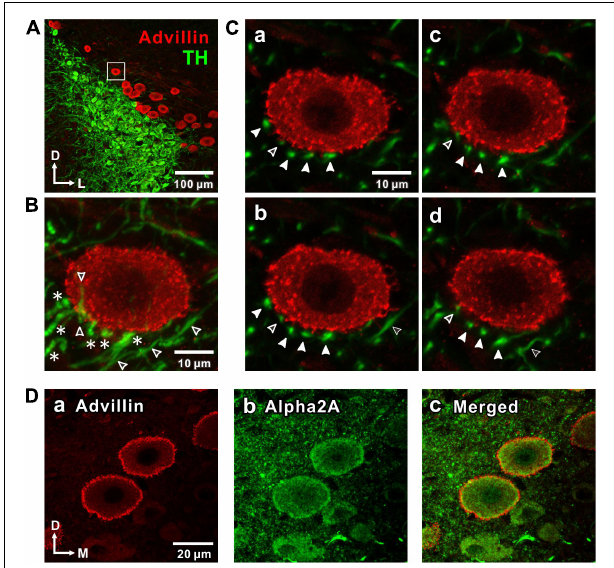
FIGURE 1 | Noradrenergic projections from the locus coeruleus (LC) to the mesencephalic trigeminal nucleus (MTN) neurons and expression of α 2 -adrenergic receptor ( α 2A -Ars) in MTN neurons. (A) A confocal image (10x magnification) of a coronal brain section showing LC nucleus and MTN, in which LC neurons were immunostained with tyrosine hydroxylase (TH; green), while MTN neurons were immunostained with advillin (red). The region enclosed with a square was further visualized at 100x magnification as shown in a larger scale in (B,C) . (B) A Z-stack projection of 8 serial confocal images of the square region taken at 1 µ m increments at 100x magnification. An advillin-positive MTN neuron is surrounded by TH-positive terminal-like swellings (filled arrowheads in C ) arising from beaded axons (asterisks). Open arrowheads indicate TH-positive unbeaded axons. (C) Four serial single plane images (a: 2nd, b: 3rd, c: 4th, d: 5th) of those 8 serial ones. Filled arrowheads indicate the distribution of terminal swellings of LC axons. Open arrowheads indicate unbeaded axons (b,d). (D) Confocal images of MTN neurons showing the immunoreactivities for advillin (a) and α 2A -ARs (b), together with a merged one